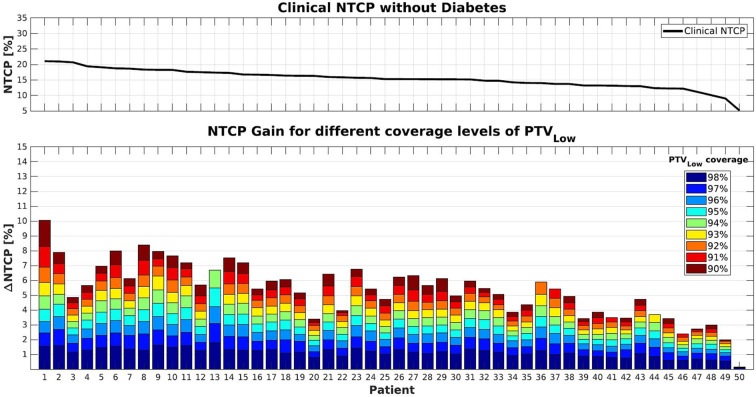
(Top) NTCP values for the clinical plans (PTVLow coverage ≥99%). (Bottom) Cumulative NTCP reductions for decreasing levels of PTVLow coverage. Patients were supposed not to have diabetes. Patient sorting along the x-axis was the same as for Figure 1.